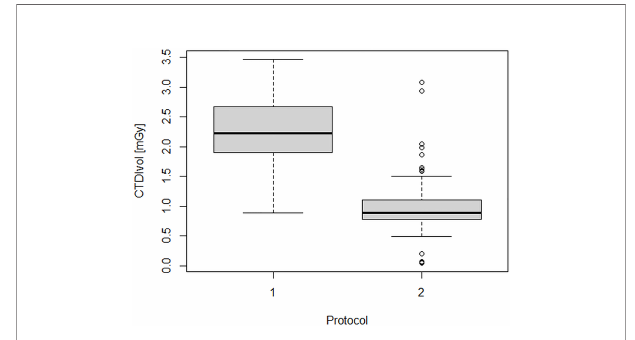
FIGURE 3 | CTDI distributions for the original protocol (1) and for the optimized protocol